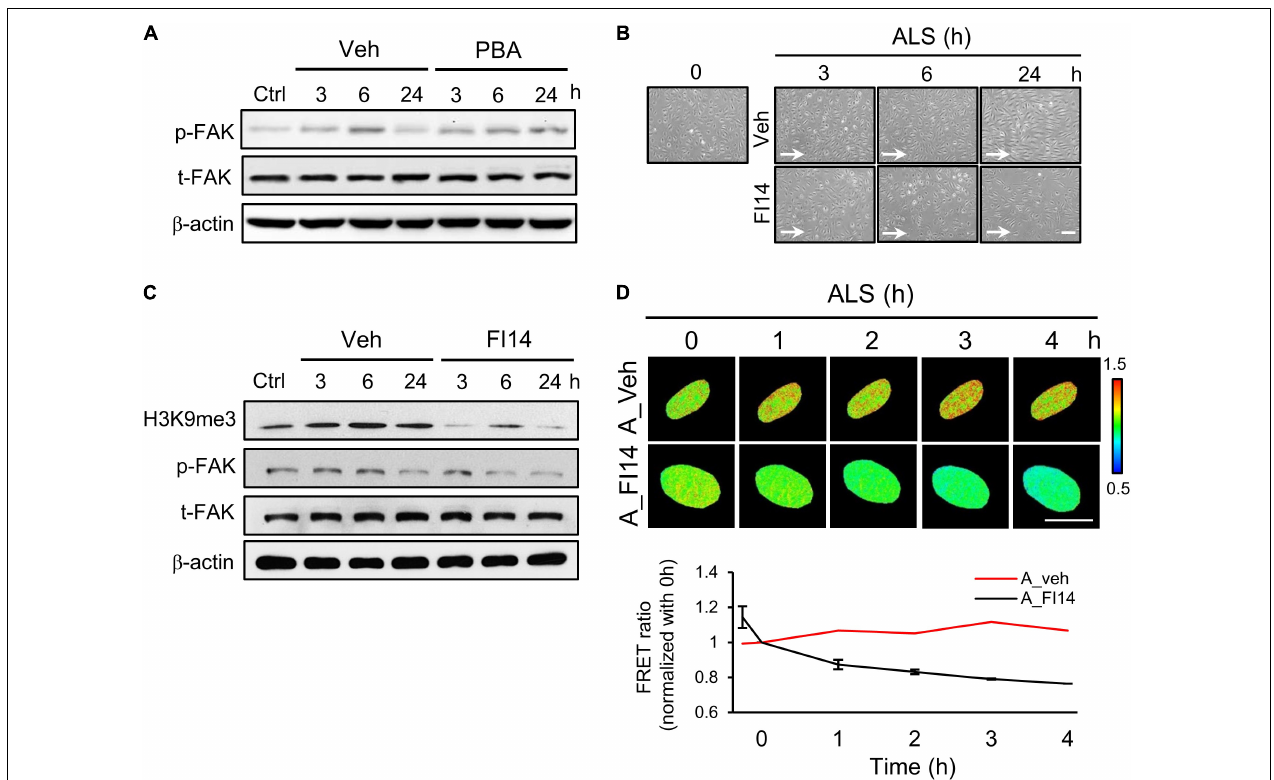
FIGURE 5 | Inhibition of FAK decreased the ALS-induced H3K9 methylation in arterial ECs. (A) The expression of p-FAK was decreased in PBA (150 µ M)-treated arterial ECs (HUVECs) by Western blotting assay after being subjected to ALS at 0, 3, 6, and 24 h. (B) ALS significantly triggered the cell peel-off in FI14-treated HUVECs at 24 h. (C) Protein expression was analyzed by using Western blotting assay against H3K9me3, p-FAK, and t-FAK. Blocking the phosphorylation of FAK by FI14 treatment decreased the expression of H3K9me3 in ALS-stimulated HUVECs. (D) The normalized H3K9me3 FRET ratio was declined in FI14-treated HUVECs after being subjected to ALS by transfecting the H3K9me3 FRET biosensor. Scale bar in (B) = 200 µ m. Scale bar in (D) = 20 µ m. Data were represented as mean ± SEM. Arrow indicated the flow direction of ALS (left to